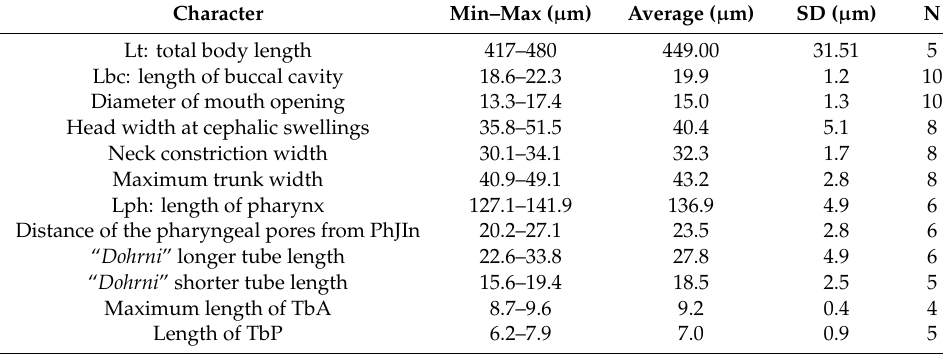
Table 2. Morphometric features of Paraturbanella tricaudata sp. nov. Min: minimum value. Max: maximum value. N: total number of measured adult specimens. SD: standard